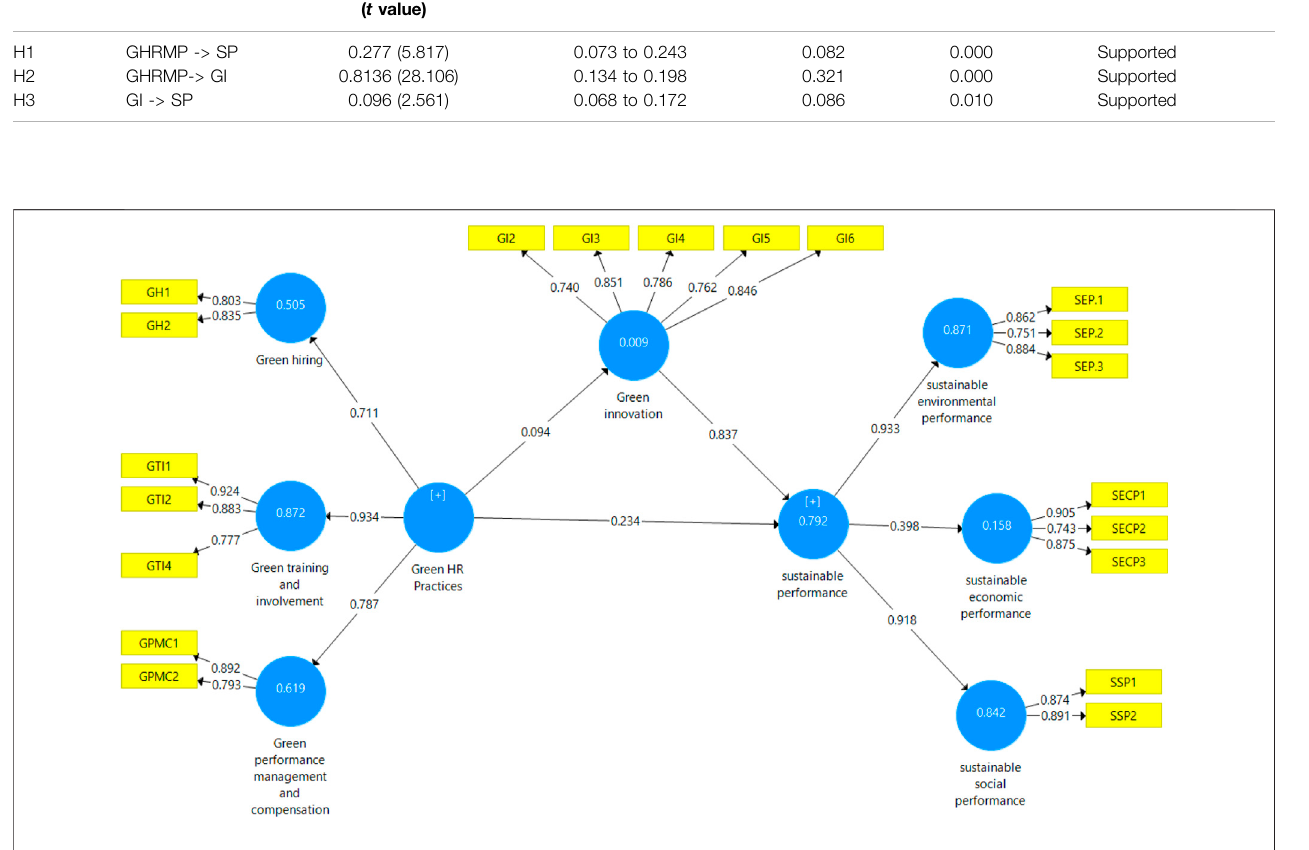
FIGURE 2 | Measurement